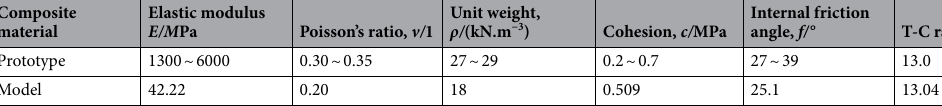
Table 3. Physical mechanical parameters of the composite material.